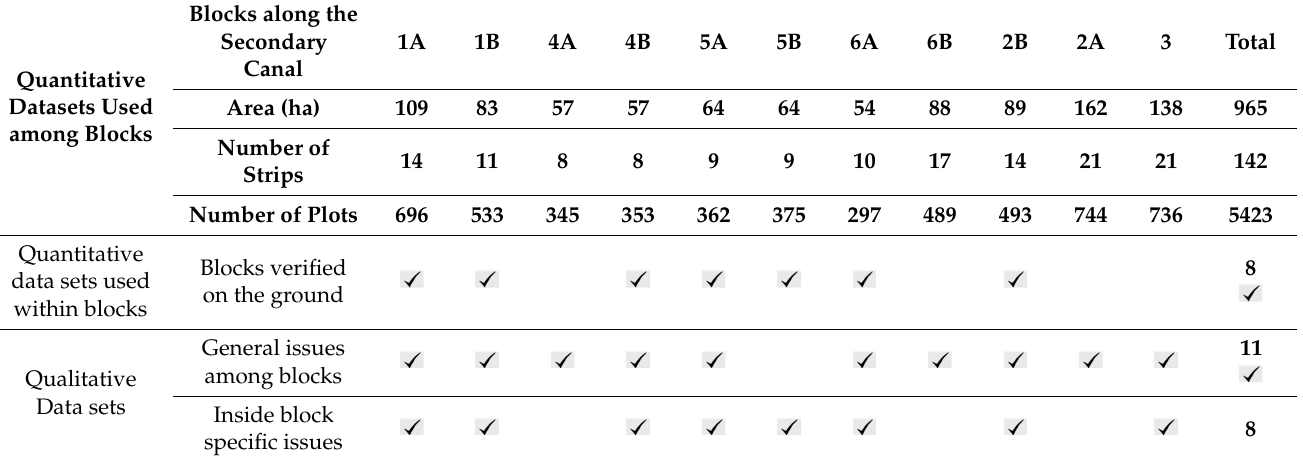
Table 1. Summary of quantitative and qualitative data